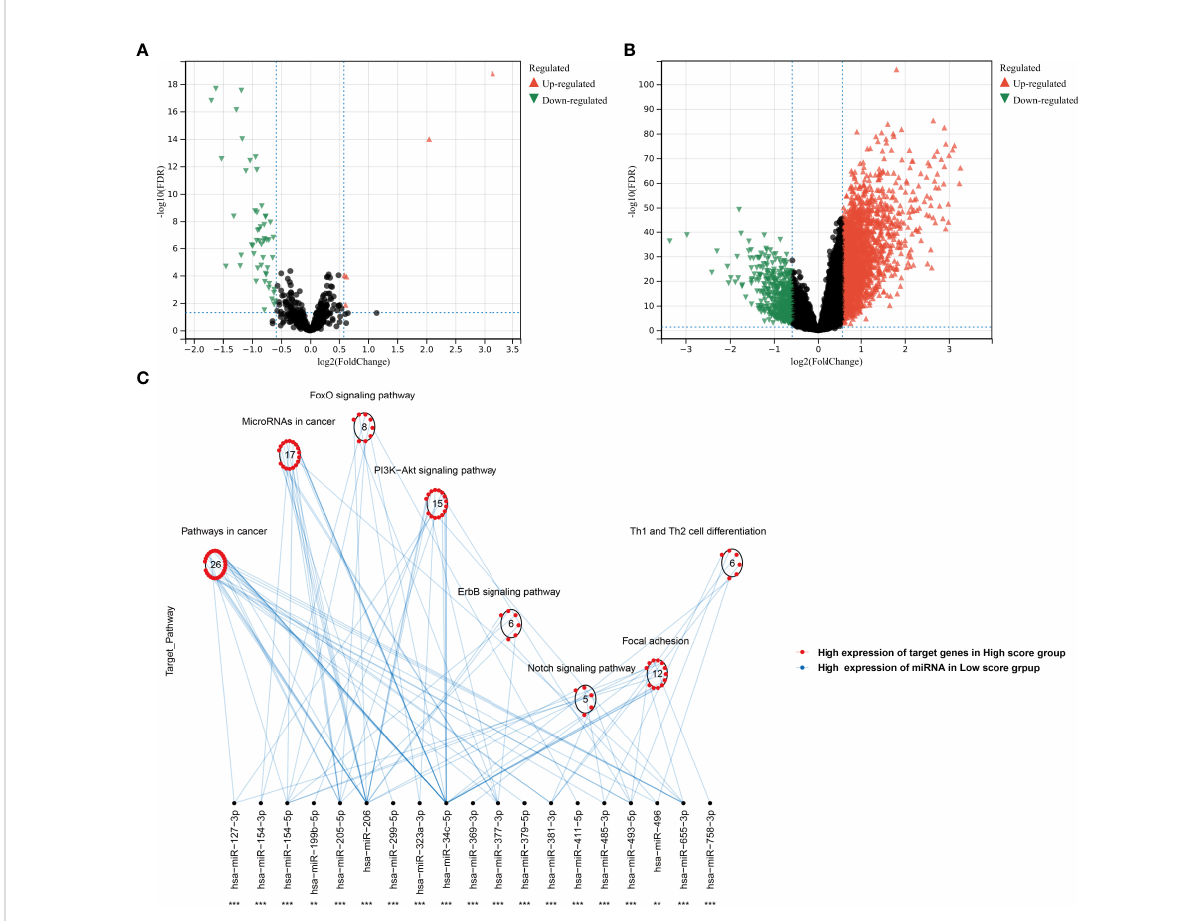
FIGURE 10 Analysis of post-transcriptional features correlated to agingScore in the TCGA-KIRC cohort. (A) Volcano diagram of differentially expressed miRNAs between the high and low agingScore groups. (B) Volcano diagram of differentially expressed RNAs between the high and low agingScore groups. Red represents upregulation, while green represents downregulation. (C) Differences in miRNA-targeted signaling pathways between the high and low agingScore groups. The red dot indicates the high expression of targeted mRNAs in the high agingScore group, while the blue dot indicates the high expression of miRNAs in the low agingScore